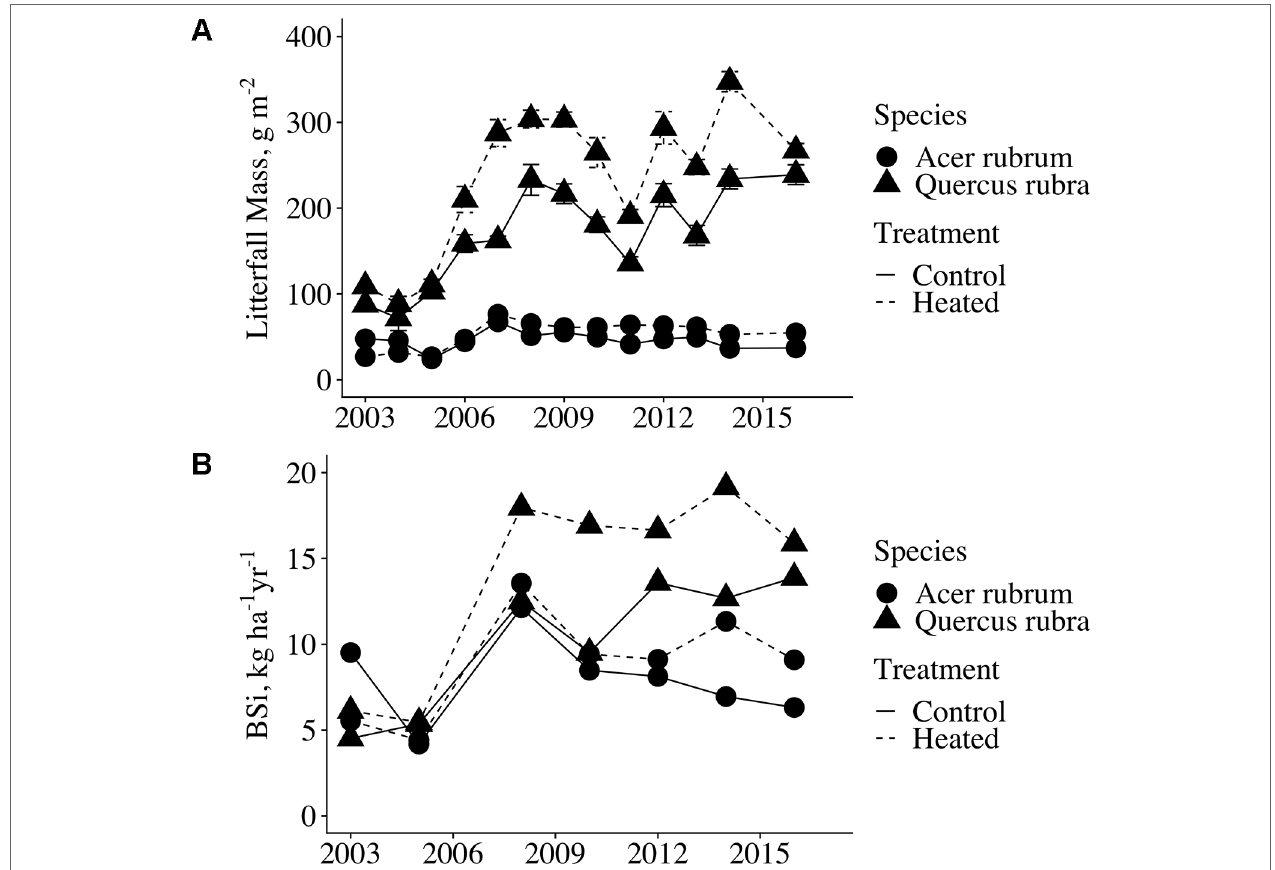
FIGURE 3 | Annual red maple and red oak litterfall mass and litterfall BSi flux. (A) The values shown here are mass per area (g m −2 ); mean across all litter baskets per plot. Error bars indicate standard error of the mean. Litterfall was collected from wire baskets dispersed throughout the plots from 2003-2006; thereafter, litterfall was collected in laundry baskets clustered in the centers of the plots. (B) Litterfall BSi flux (kg BSi ha −1 yr −1 ) was calculated by multiplying mean BSi concentration by mean litterfall mass per area for each year analyzed. Error bars are not shown as measurements were calculated for only the single control plot and the single heated